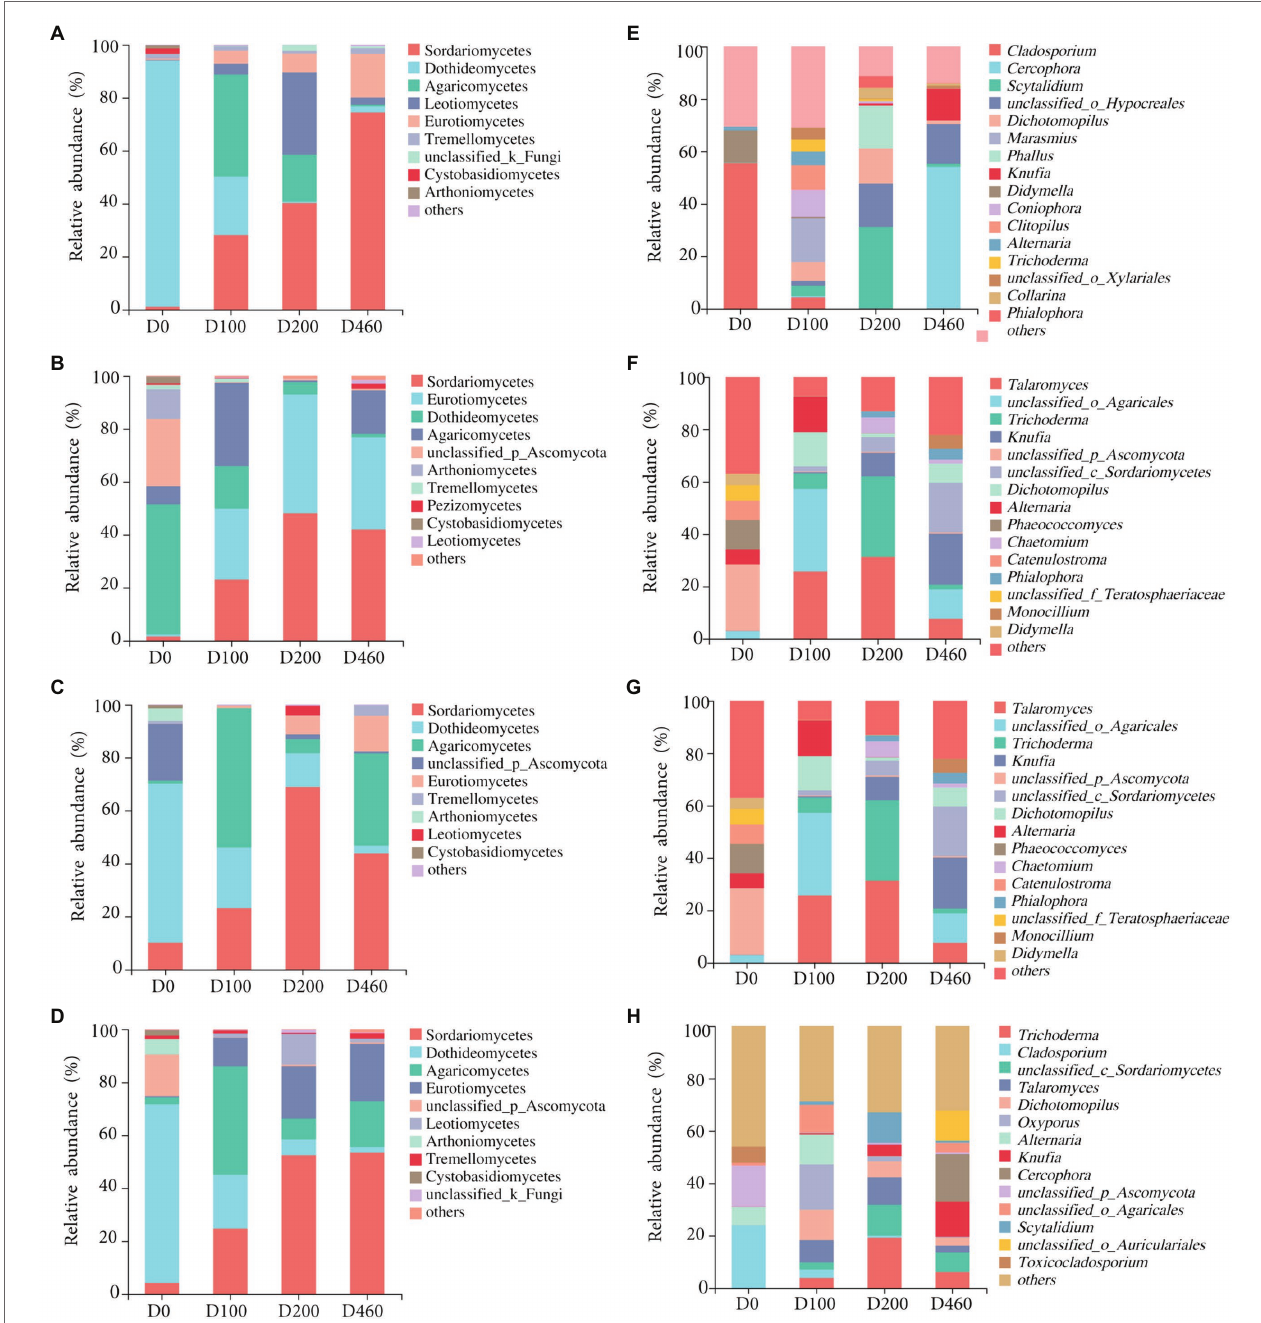
FIGURE 3 | Litter fungal community compositions with relative abundance greater than 1 and 4% at class (A-D) and genus level (E-H) , respectively, in S516 (A , E) , S536 (B , F) , S560 (C , G) , and the whole copper mining area (D , H) .